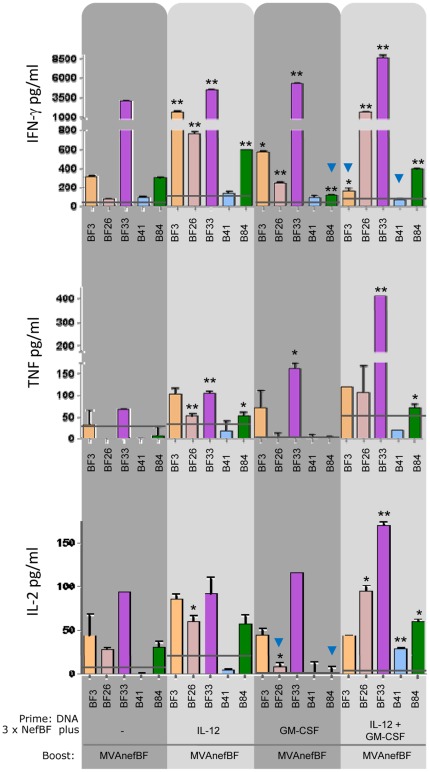
IFN-γ, TNF and IL-2 secretion pattern after re-stimulation with homologous or heterologous peptides.Spleen cells from mice immunized with 3xDNA/MVAnefBF plus IL-12 or/and GM-CSF (as depicted in Figure 1) were re-stimulated during 72 h with the indicated peptides. Levels of IFN-γ, TNF and IL-2 secreted in supernatants were quantified by ELISA. Bars represent the average levels of cytokines secreted in cell supernatants from pooled samples of triplicate cultures. Negative controls (RPMIc) values were subtracted (<130 pg/ml for IFN-γ, <30 pg/ml for TNF and <14 pg/ml for IL-2). Cut-off levels (RPMI values+2xSD) are shown by horizontal grey lines. Significant differences between responses found in control vs the other three groups are indicated with ** (p<0.01) and * (p<0.05).